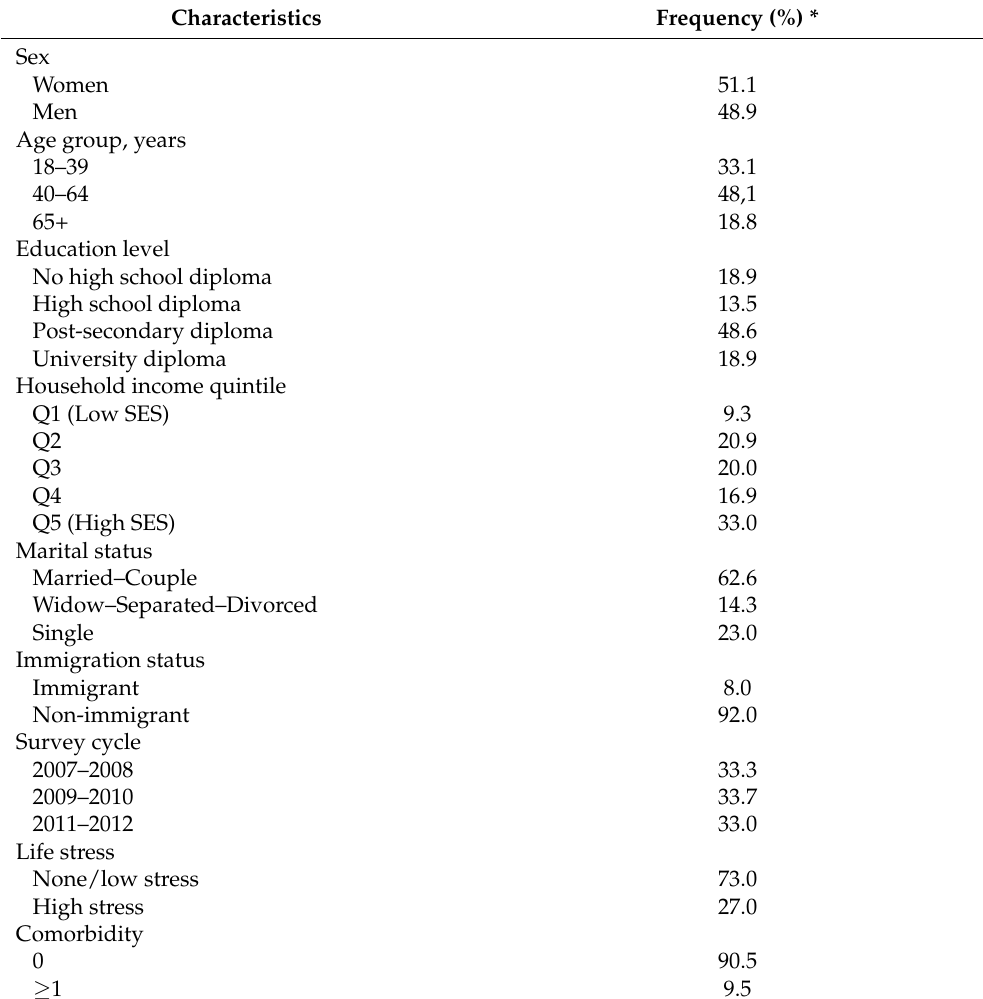
Table 1. Demographic characteristics of study sample ( n = 45,990).